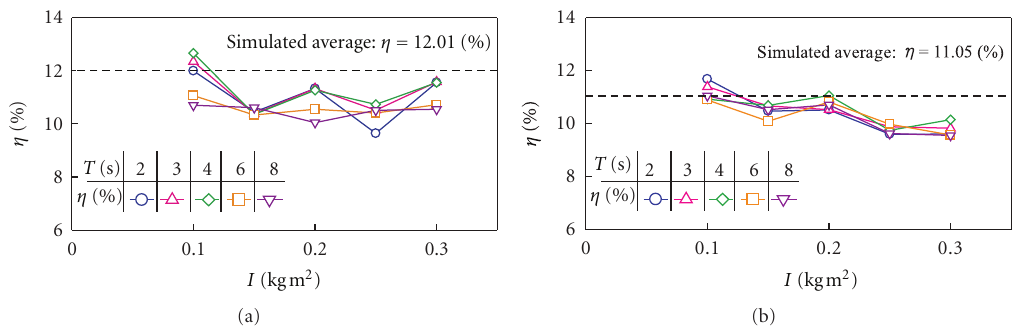
Figure 11: Energy e ffi ciency, η , for wind amplitude (a) Δ V = 1 and (b) Δ V = 2 m/s.